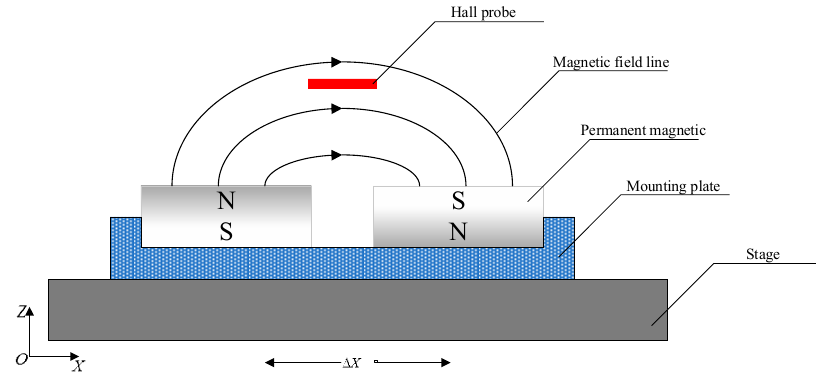
Figure 2. The structure of the designed Hall sensor.